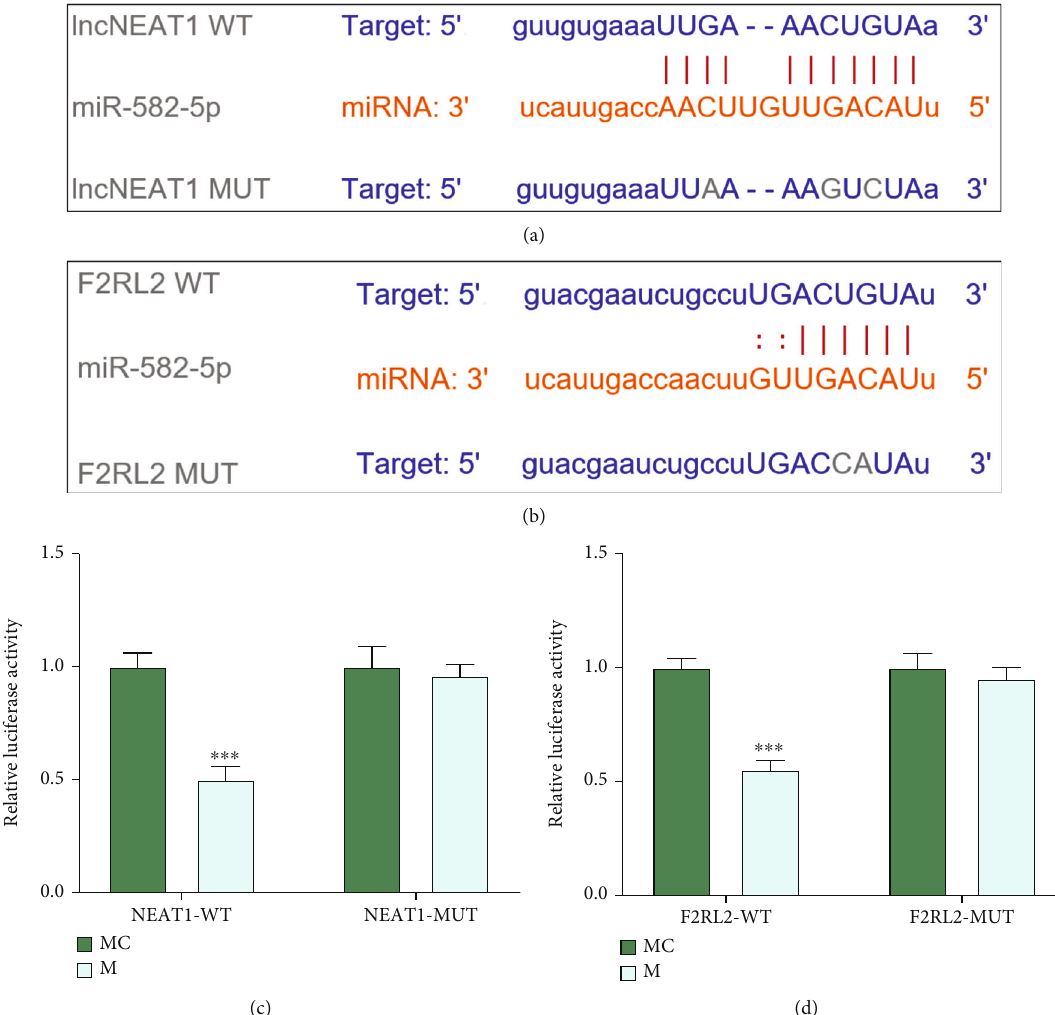
Figure 6: F2RL2 was targeted by miR-582-5p which was sponged by NEAT1 in HCMs. (a, b) The binding sites between NEAT1 with miR- 582-5p (a) and between F2RL2 with miR-582-5p (b) were predicted through StarBase. (c, d) The targeting relationships between NEAT1 with miR-582-5p (c) and between F2RL2 with miR-582-5p (d) in HCMs were veri fi ed by dual-luciferase reporter assay. ( ∗∗∗ P < 0 : 001 , vs. MC) (HCMs: human cardiac myocytes; F2RL2: coagulation factor II thrombin receptor like 2; NEAT1: nuclear paraspeckle assembly transcript